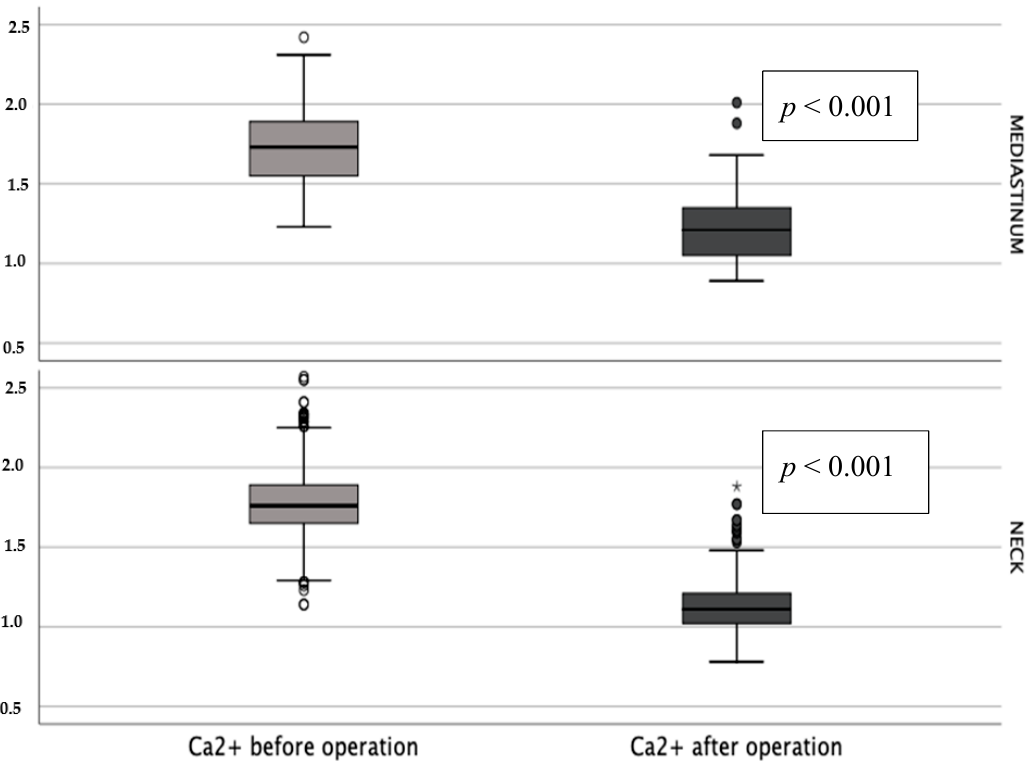
Figure 2. Blood serum Ca 2+ concentration before and after operation (* - p < 0.001).